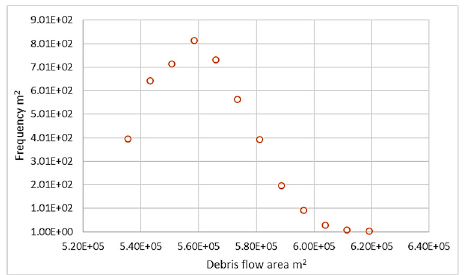
Figure 8. Landslide distribution in the study area: distribution of the surface area of landslides ( a ), distribution of the number of landslides ( b ), percent of surface area affected by landslides concern- ing the total surface area ( c ), landslides distribution (%) by geological formations ( d ).